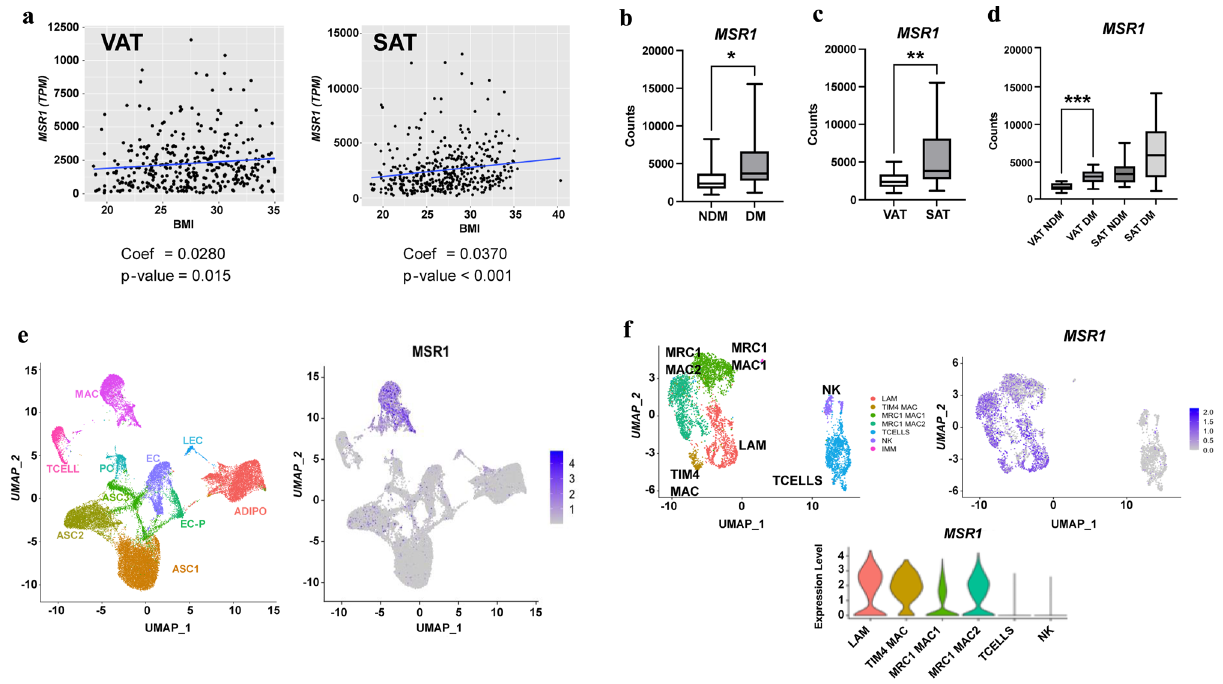
Figure 1. MSR1 gene expression is increased in diabetic visceral adipose tissue in humans. ( a ) Correlation between MSR1 expression and BMI in omental/visceral (VAT; n = 354) and subcutaneous (SAT; n = 439) adipose tissue in GTEX. Negative binomial model used incorporating BMI, sex, and age in the model. ( b – d ) MSR1 expression from RNAseq data from independent cohort of VAT and SAT samples (n = 40). Corrected counts reported comparing ( b ) non-diabetic (NDM) and diabetic (DM), ( c ) VAT and SAT, and ( d ) depots stratified by DM status. * p -value < 0.05. ** p -value < 0.01. *** p -value < 0.001. ( e ) UMAP plots from single nuclear RNAseq data from human VAT and SAT identifying major cell types. MSR1 expression shown restricted to macrophages (MAC) cells. ( f ) Subcluster analysis of macrophages and T cells from single nuclear RNAseq analysis identifying lipid associated macrophages (LAM), TIM4 macrophages, and two types of MRC1 macrophages. MSR1 expression identified in all ATM